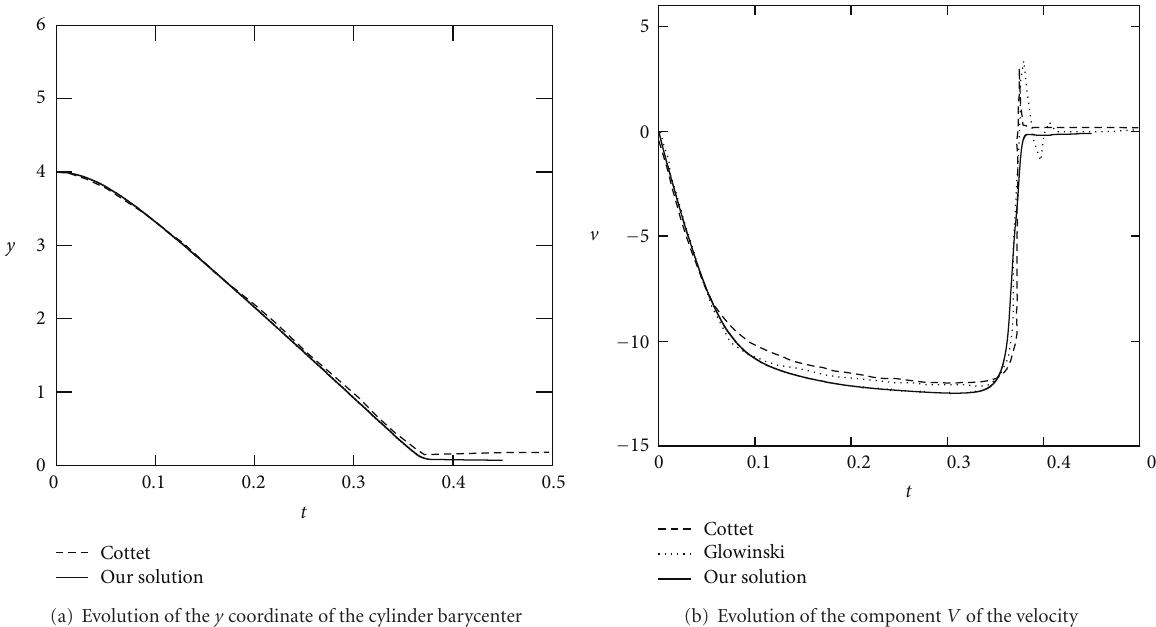
Figure 4: Sedimentation of a 2D cylinder on a flat plate.